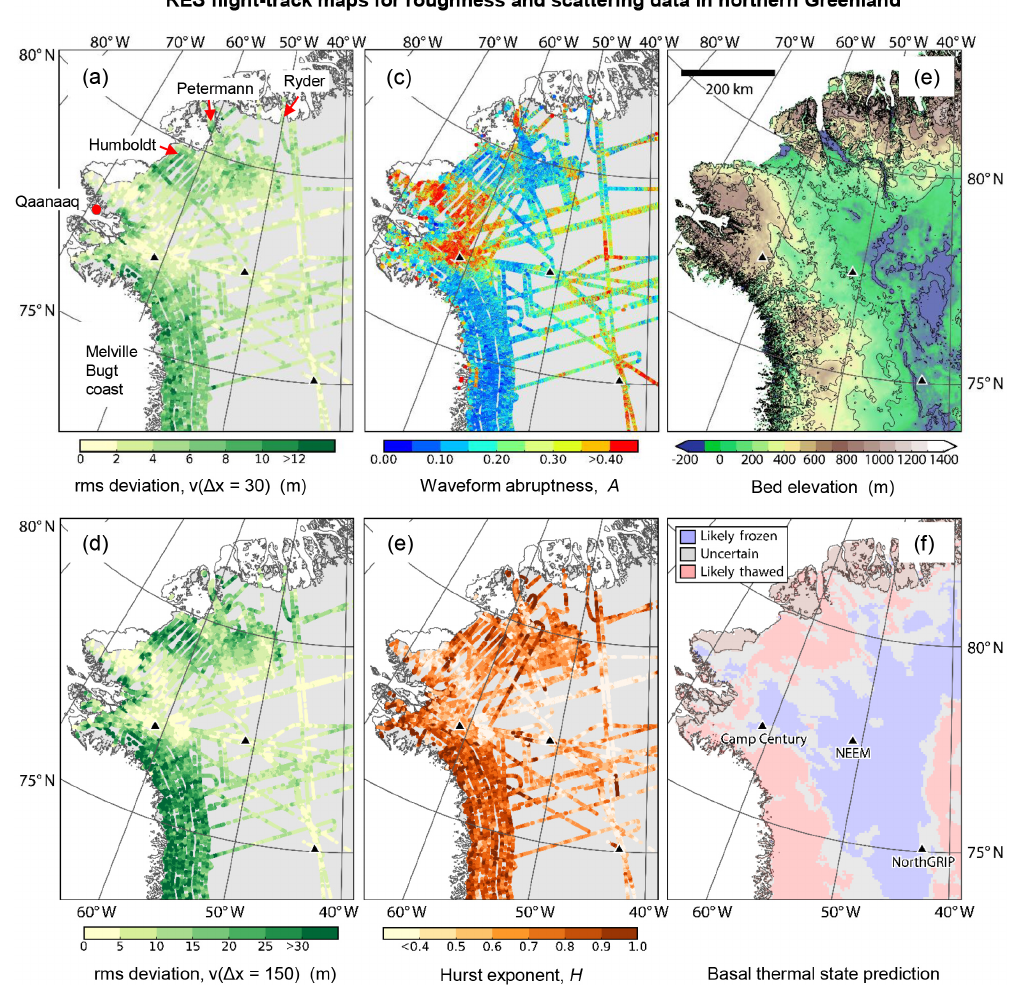
Figure 6. Data maps for the northern GrIS: (a) rms deviation (topographic roughness) at ∼ 30m lag, ν((cid:49)x = 30m); (b) rms deviation at ∼ 150m lag, ν((cid:49)x = 150m); (c) waveform abruptness (degree of radar scattering), A ; (d) Hurst exponent, H . (e) Greenland bed DEM (black contour lines at 200m intervals) (Bamber et al., 2013a); (f) predicted basal thermal state mask (MacGregor et al., 2016). Higher values of A in (c) indicate more specular